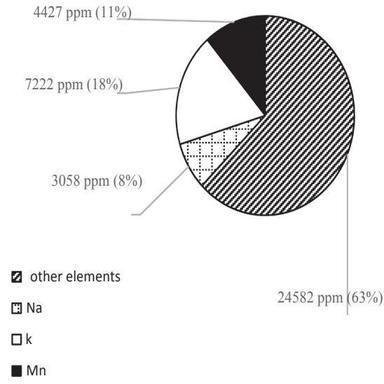
ICP plasma spectroscopy data concentrations of alkali metals in slag sample.